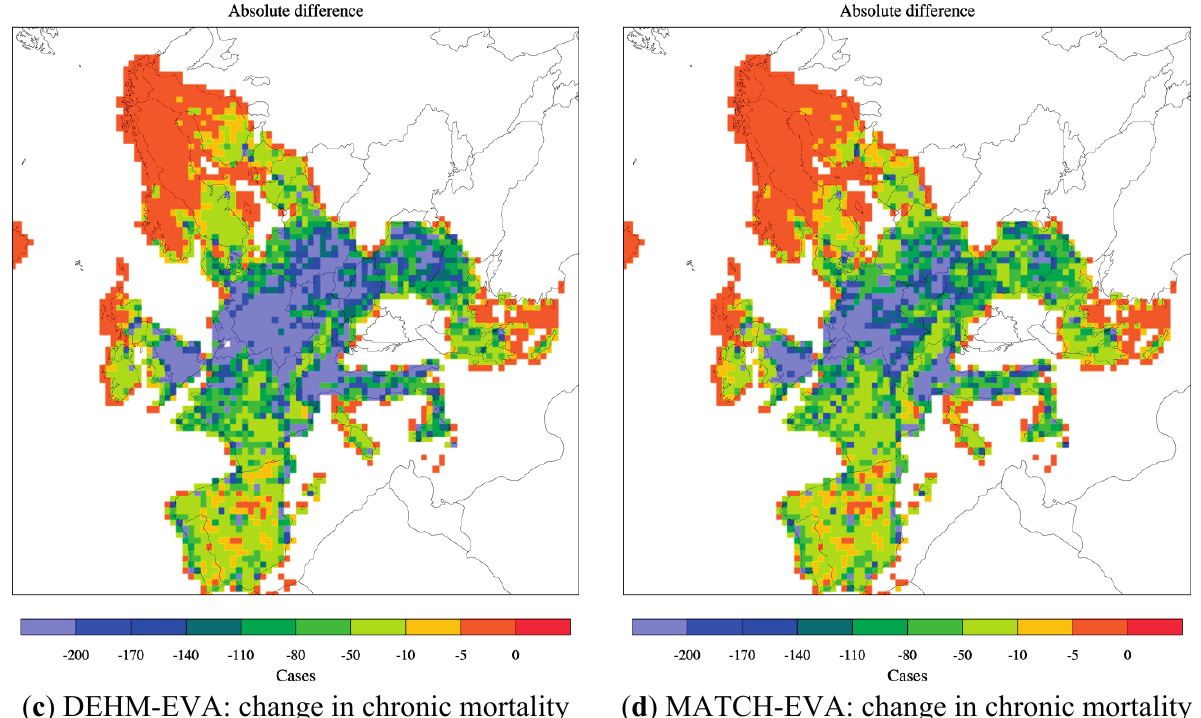
Figure 9. Combined climate and emission changes: change in (absolute difference) acute ( a and b ) and chronic mortality ( c and d ) from present (2000s) to future (2080s) as estimated by DEHM-EVA (a and c) and MATCH-EVA (b and d). The colour bar refers to number of cases per year per 2500 km 2